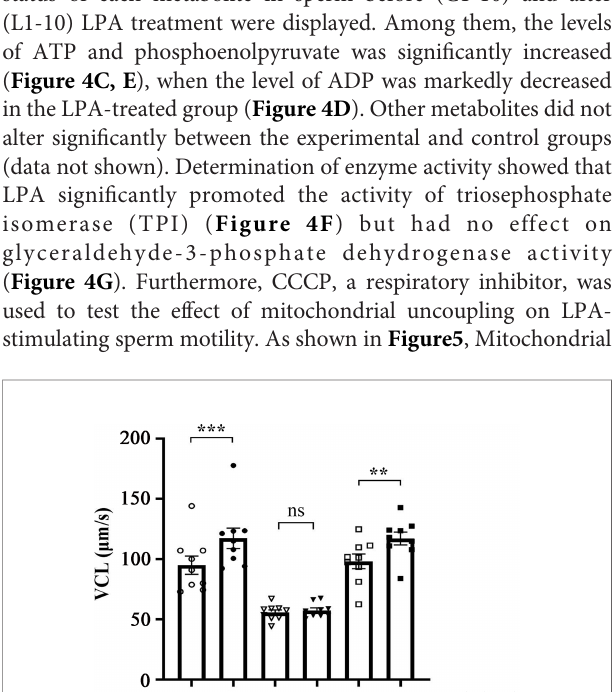
( Figure 2D ) between the experimental and control groups. Furthermore, the experiment in which BSA was replaced with b -cyclodextrin showed that LPA had no positive effect on sperm motility parameters in the absence of BSA ( Figure 2B ).